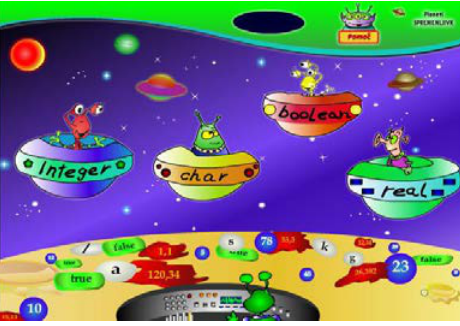
Figure 4. Fourth game – Acquisition of the